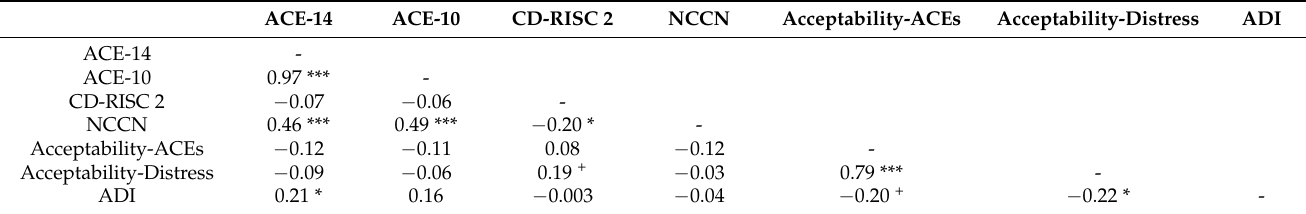
Table 3. Correlations for Caregiver Variables and Socioeconomic